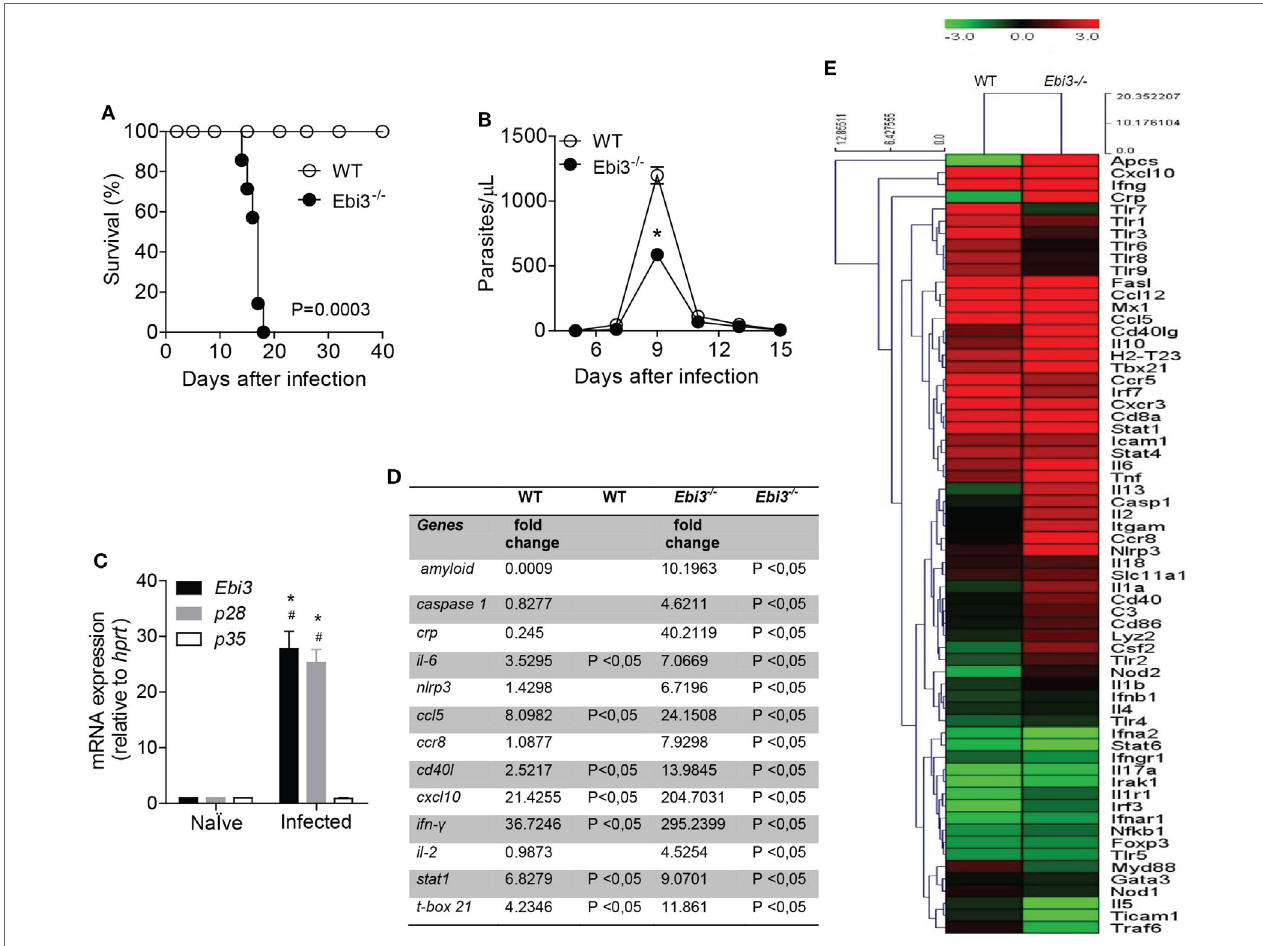
FigUre 2 | IL-27 is required for host protection by regulating several inflammatory molecules in the myocardium of Trypanosoma cruzi -infected mice . (a) The survival rate of wild-type (WT) and Ebi3-deficient mice infected intraperitoneally with 10 3 trypomastigostes of T. cruzi was observed for 40 days. (B) The number of parasites in the bloodstream was counted from peripheral blood. Results are representative of three independent experiments ( n = 8). Data are expressed as mean ± SEM ( P < 0.05). (c) The mRNA expression from the heart tissue of Ebi3, p28, and p35 was evaluated at 9 d.p.i by real-time qPCR ( n = 4). # P < 0.05 compared to naïve group. * P < 0.05 compared to expression of p35. (D) Most significant genes expressed 7 d.p.i with T. cruzi after analysis of gene expression by PCR array in heart tissue (data represented as fold change). (e) Hierarchical clustering showing gene expression in cardiac tissue of WT ( n = 5) and Ebi3-deficient mice ( n = 5) 7 days after infection with 10 3 trypomastigotes of T. cruzi relative to non-infected mice ( n = 5). The heat maps display the fold change expression of the genes. The color scale represents log2 transformation of % of reads. The transition of colors from green to red represents an average of lowest to highest fold change found ( P < 0.05). The clustering method used was Euclidian distance with average linkage. Data are representative of two independent